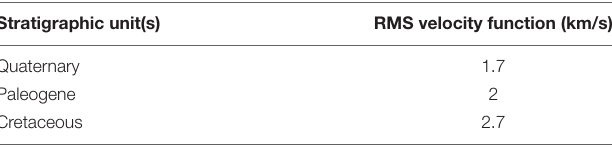
TABLE 1 | Interval velocities of the Quaternary, Paleogene, and Cretaceous sections and depth conversion equation (Guo et al., 2014; Guo, personal comm.